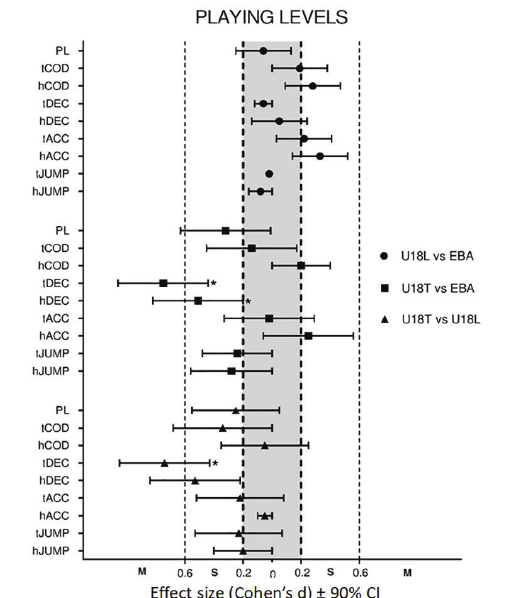
Figure 1. Effect size (Cohen’s d) with 90% confidence interval on the differences between the three competitions (EBA, U18L and U18T). PL is Player Load per player; tCODmin is the total number of movements to the right / left; hCOD is the number of movements to the right / left above the high-intensity threshold (> 3 m x s -2 ); tDEC is the total number of decelerations; hDEC is the number of high-intensity decelerations (< -3 m x s -2 ); tACC is the total number of accelerations; hACC is the number of high- intensity accelerations (> 3 m x s -2 ); tJUMP is the total number of jumps; hJUMP is the number of jumps above 40